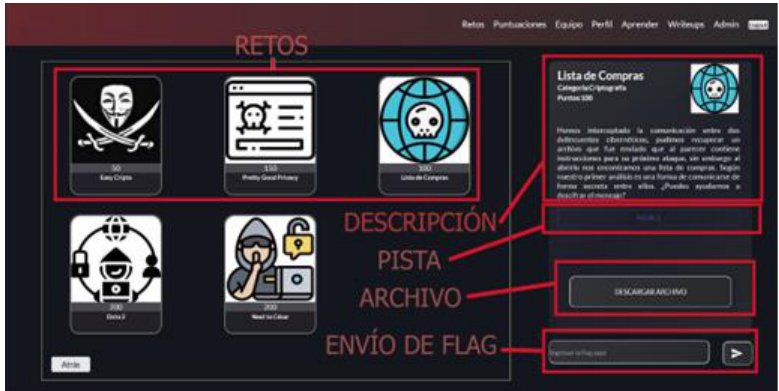
Figure 5. Challenge interface included in the CTF platform.